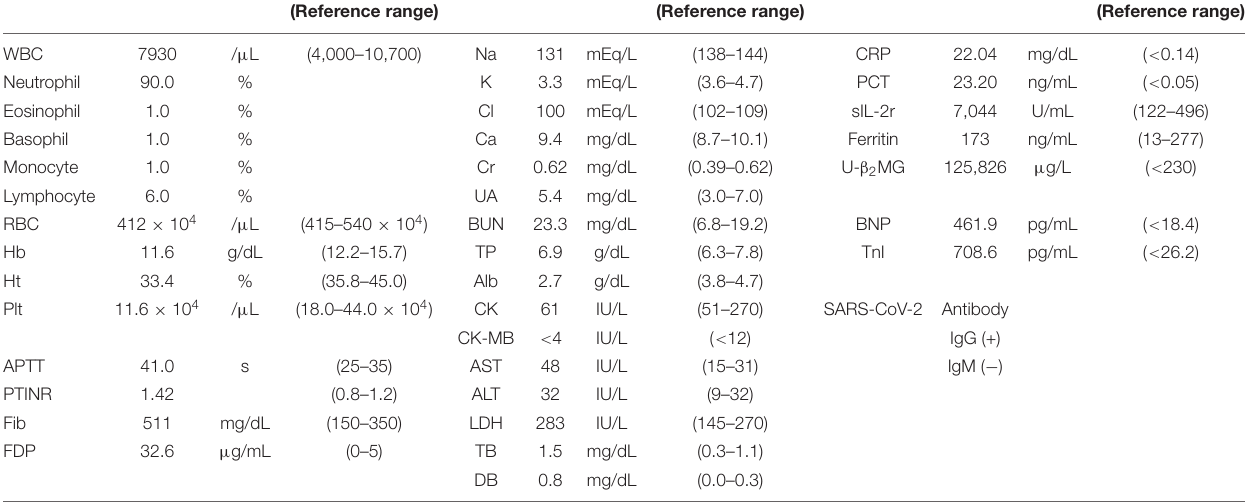
TABLE 1 | Laboratory data on admission.